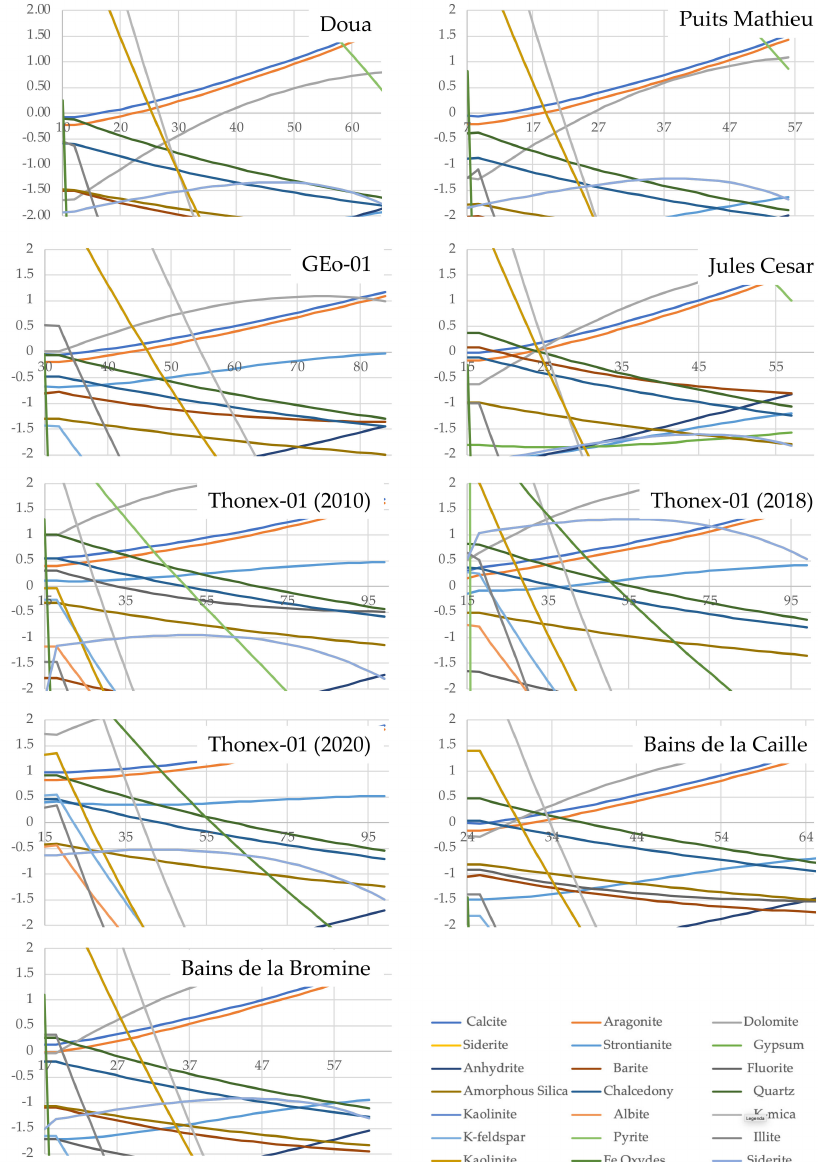
Figure 7. Saturation indexes evolution with temperature for the samples in the Geneva